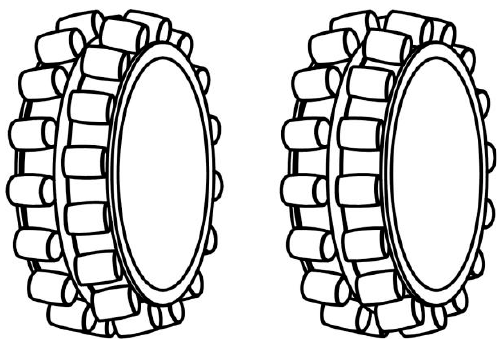
The corner marks “ left ” and “ right ” mean the left and right rows, respectively.